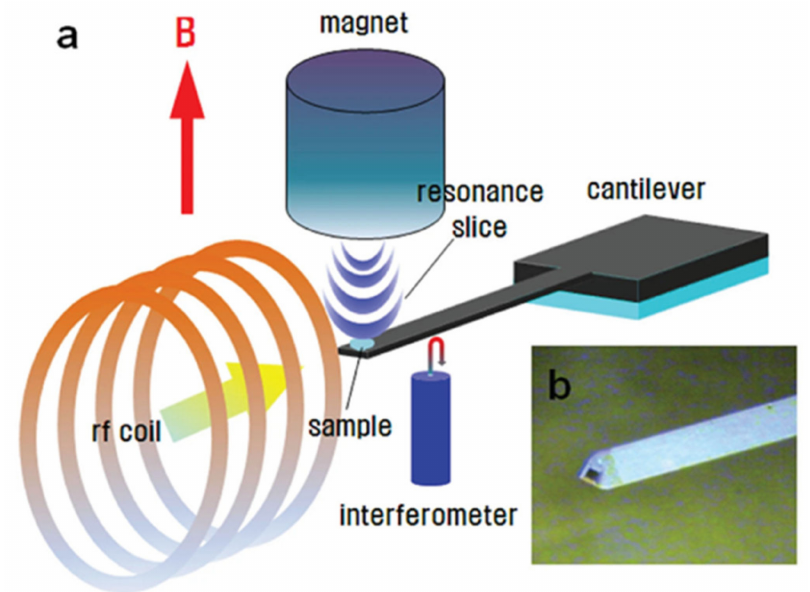
Figure 7. ( a ) A schematic description of the MRFM setup and ( b ) showing the original cantilever tip where the sample is deposited (appearing dark). Reproduced with permission. [77] Copyright 2013,